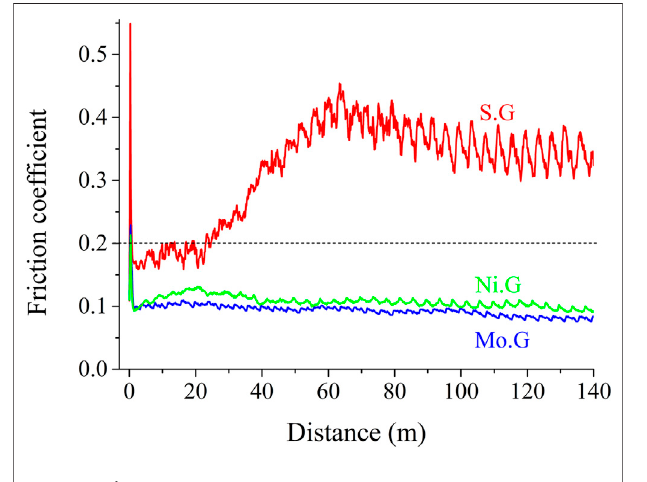
FIGURE 9 | Evolution of the COF in tests under constant normal load (7 N).